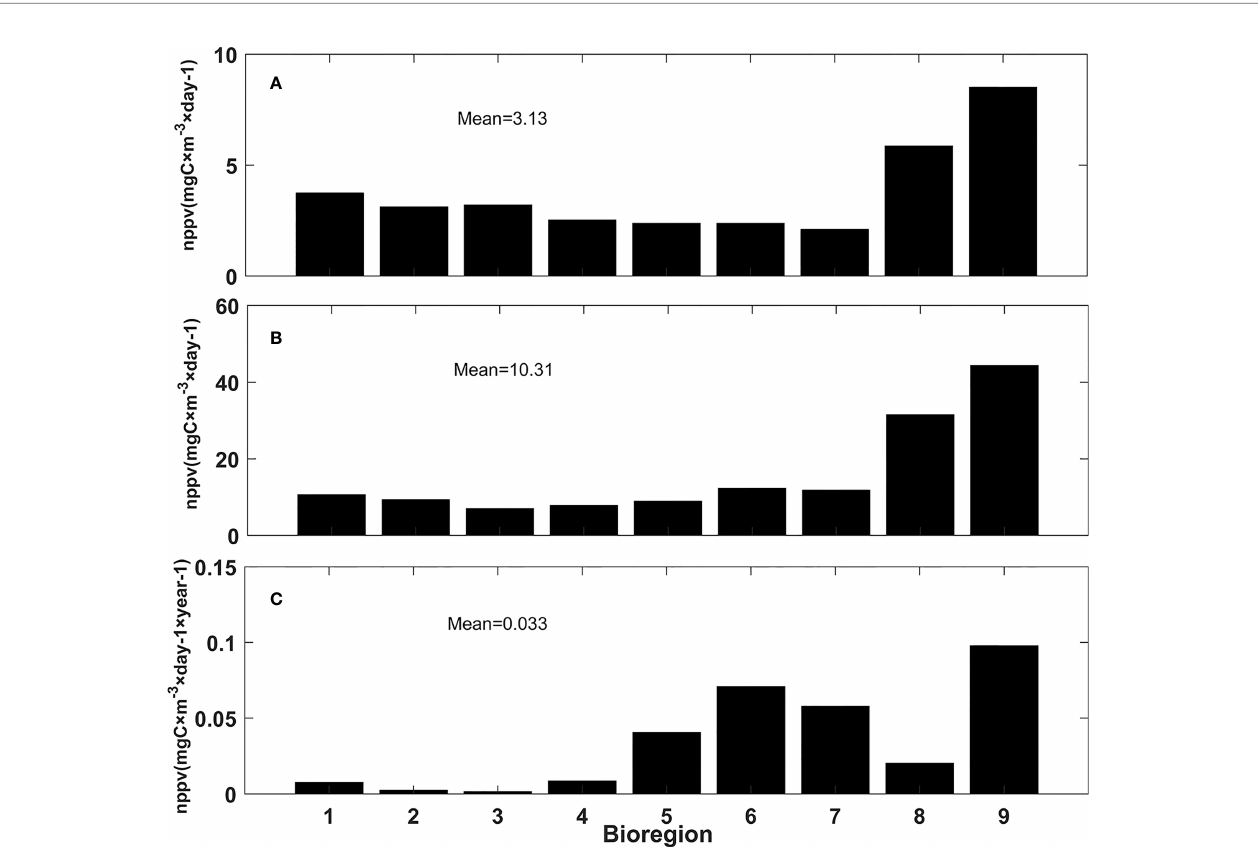
FIGURE 6 | Mean values (A) , annual maximum mean values (B) , and long-term change rates (C) of primary production in 9 bioregions, the mean value of the whole bioregions was also listed in the fi